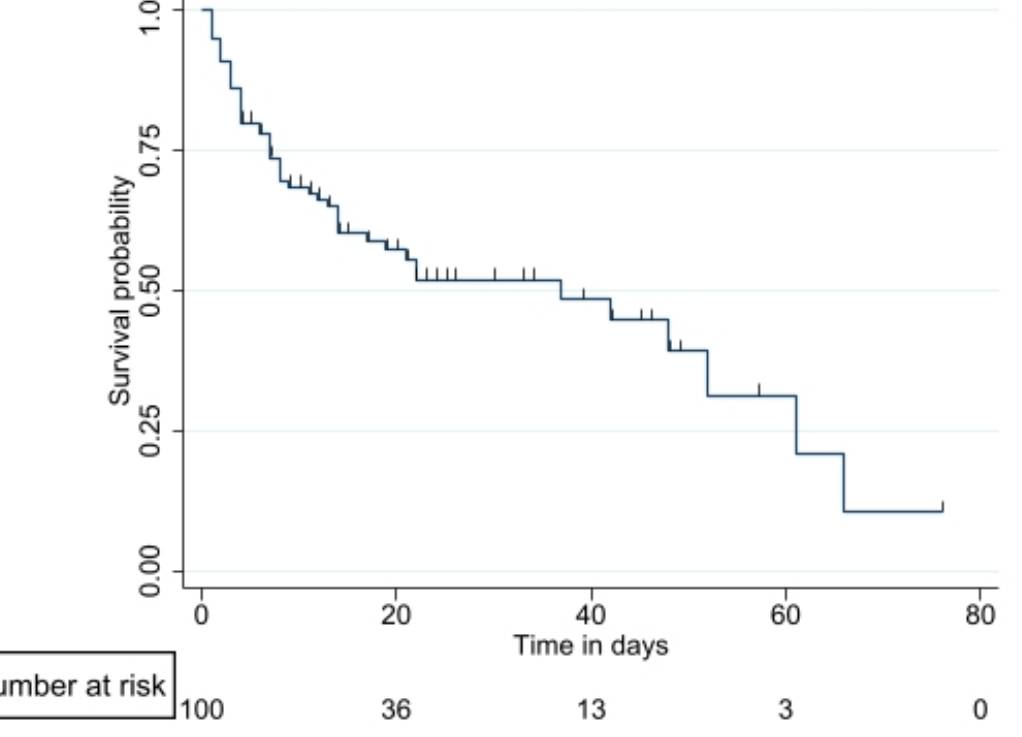
Figure 2. Kaplan–Meier overall survival curve.